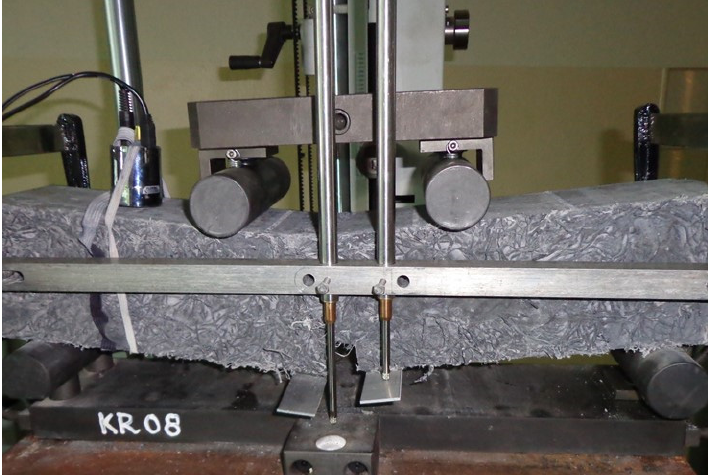
Figure 9. The four-point bending test, paste ZV f 6% after the test.